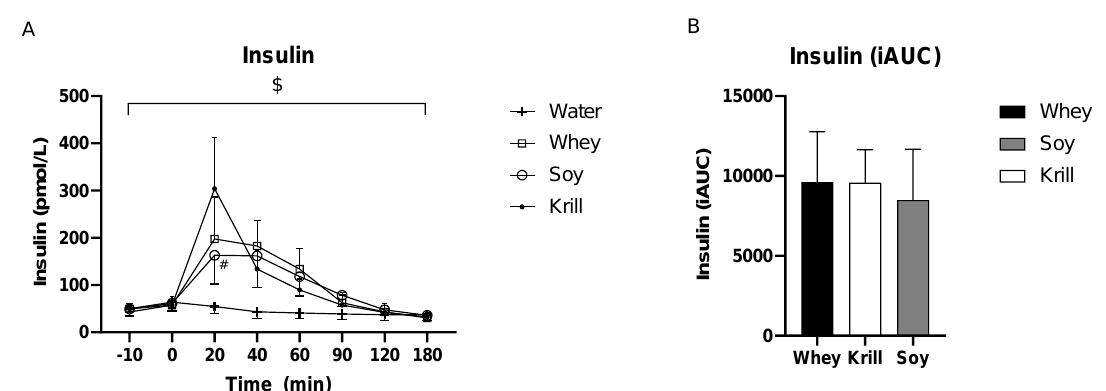
Figure 4. ( A ) Serum insulin concentration over time and ( B ) area under the curve (iAUC) analyses for serum insulin concentration. $ p < 0.001 time × treatment interaction. # Significantly different from KRILL.